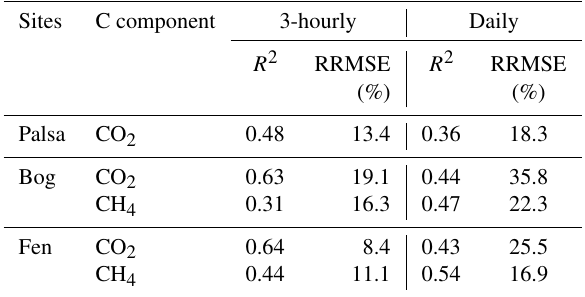
Table 2. Evaluation of the 3-hourly and daily CO 2 and CH 4 ex- changes simulated in the palsa, bog, and fen